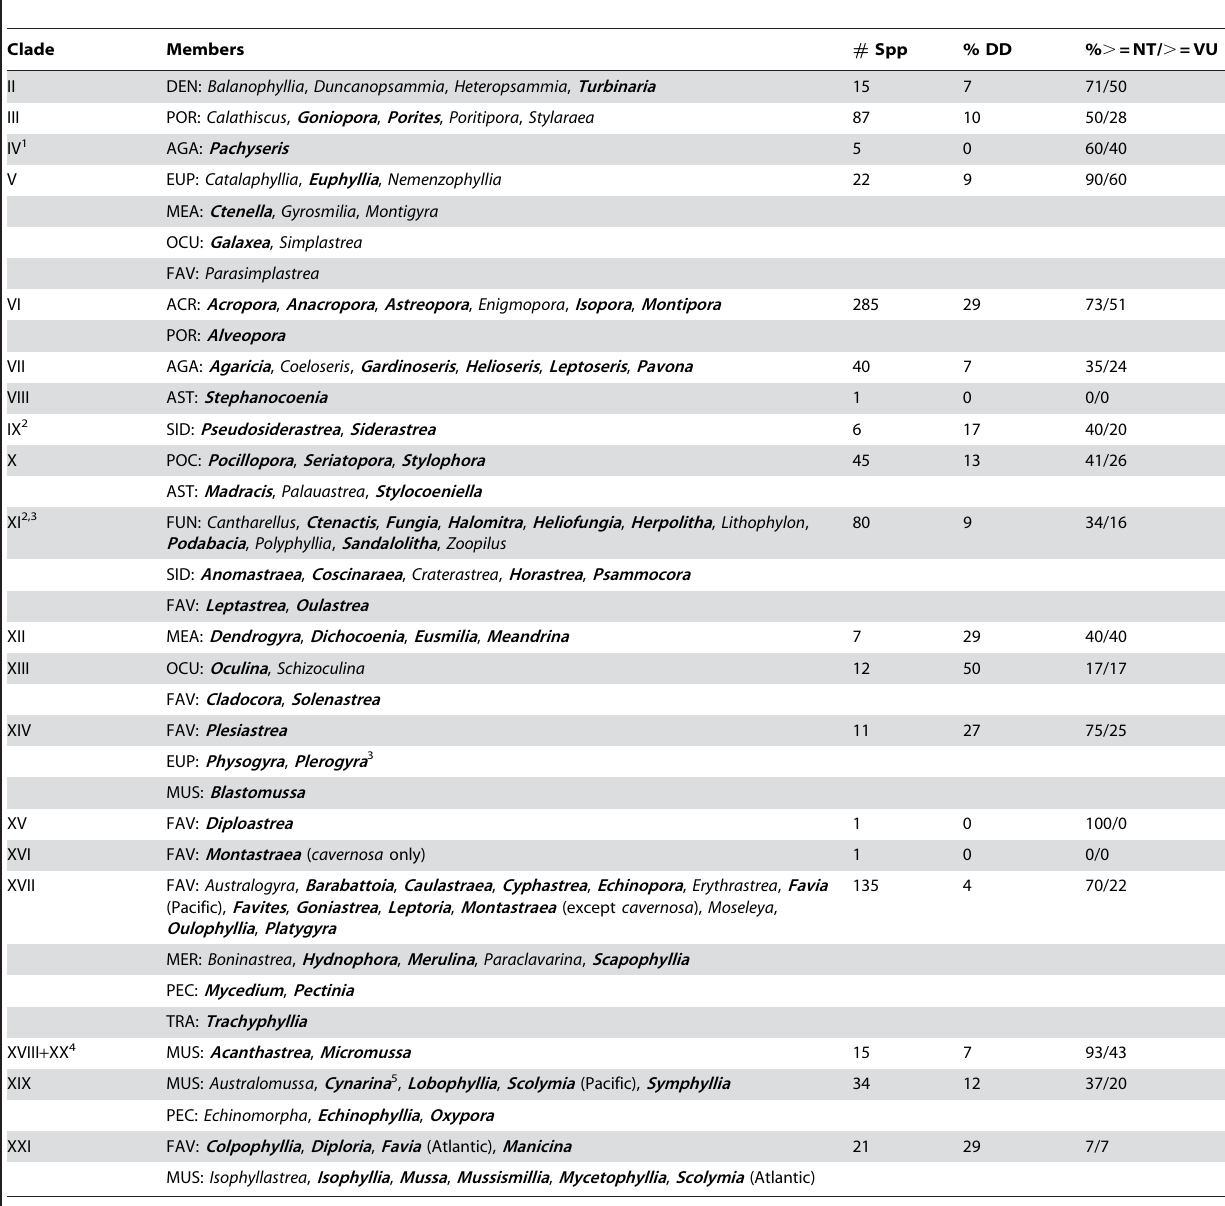
Table 2. Tentative groupings of reef-building scleractinian genera based on molecular clades, with total number of species, % data deficient species, and % threatened species for each